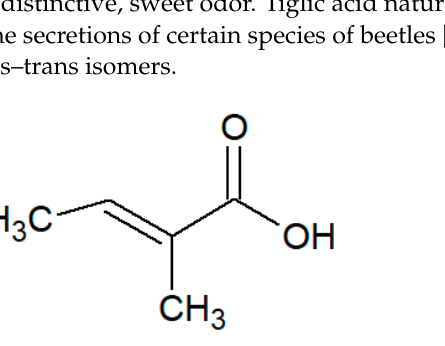
Figure 1. The chemical formula of tiglic acid.